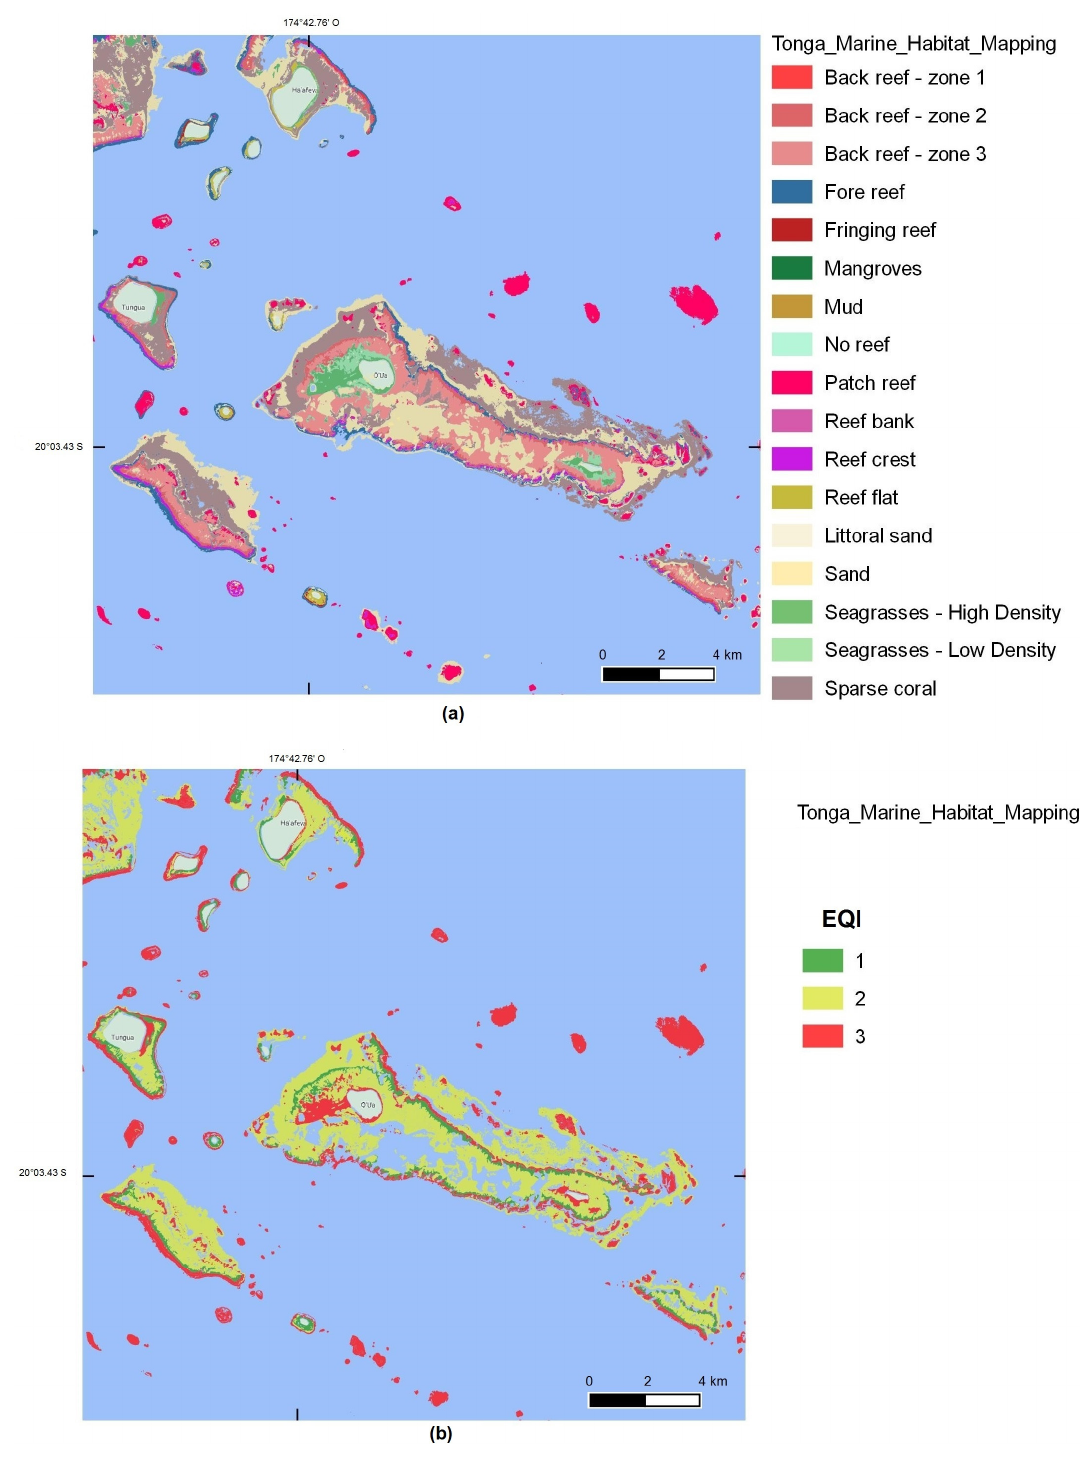
Figure 2. Examples of the QGIS outputs of one area selected in the Ha’apai Region of Tonga Archipelago: ( a ) Habitat map; ( b ) Ecological Quality Index (EQI) map (1 = low ecological value; 2 = medium ecological value; 3 = high ecological